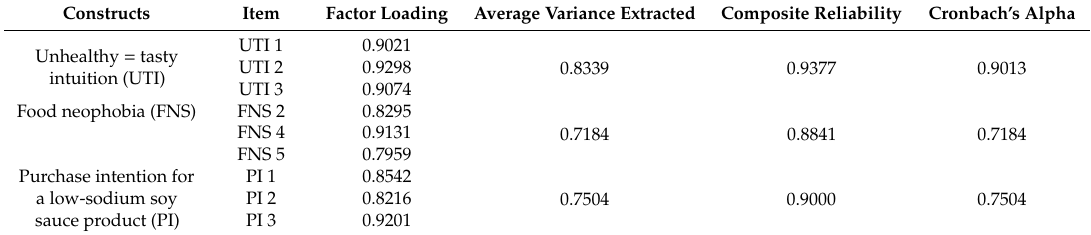
Table 4. Reliability and validity values from the first experiment: soy sauce products.